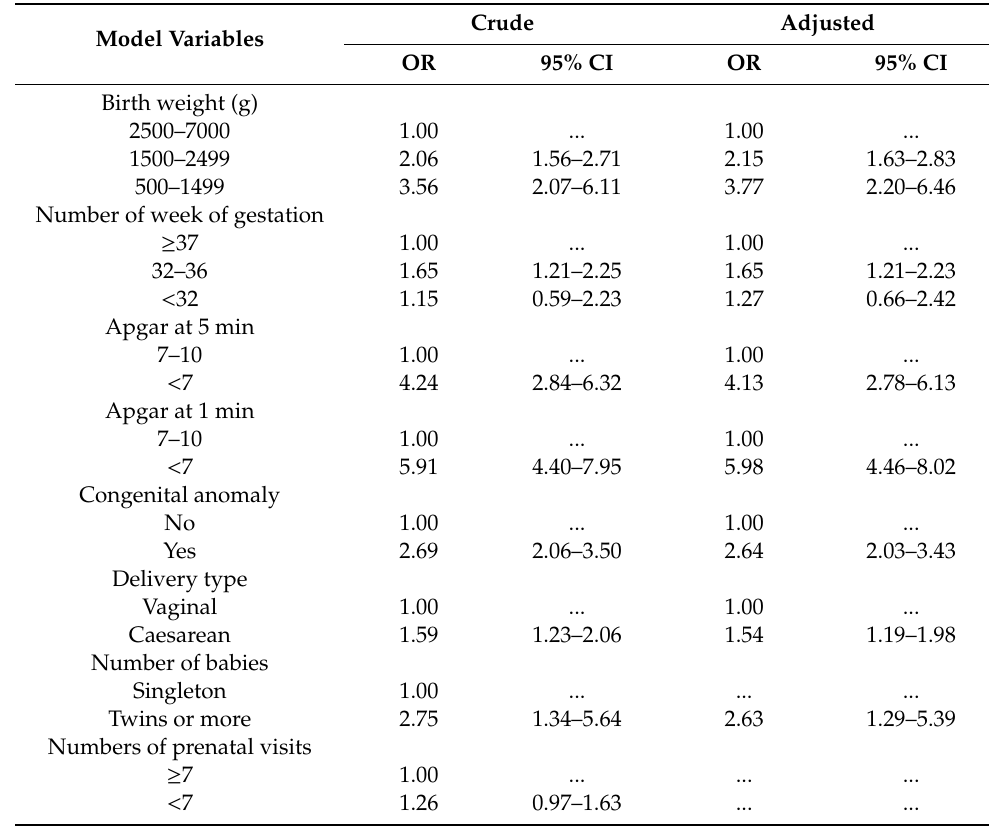
Table 4. Odds ratios (ORs) and confidence intervals (95% CIs) obtained by logistic regression for the association between deaths of live birth with congenital Zika syndrome (confirmed and possible a ) and potential risk factors. Brazil,